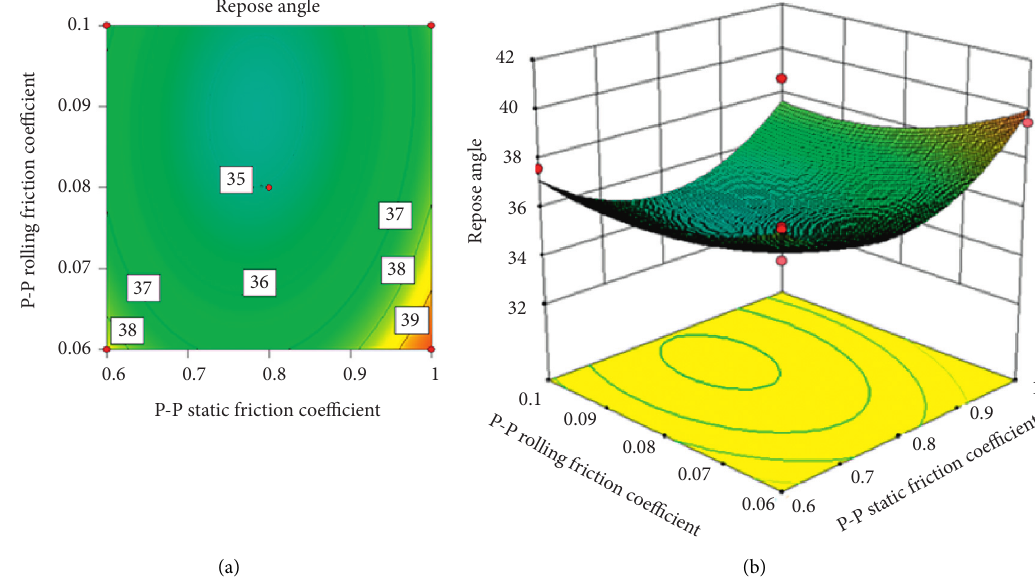
Figure 12: The plot of contour and response surface (P-P static friction coefficient and rolling friction coefficient) (a) The contour plot (b) The response surface plot.